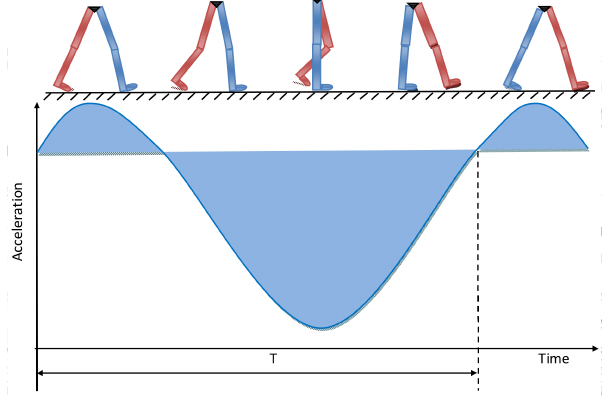
Figure 1. The relationship between the vertical acceleration and